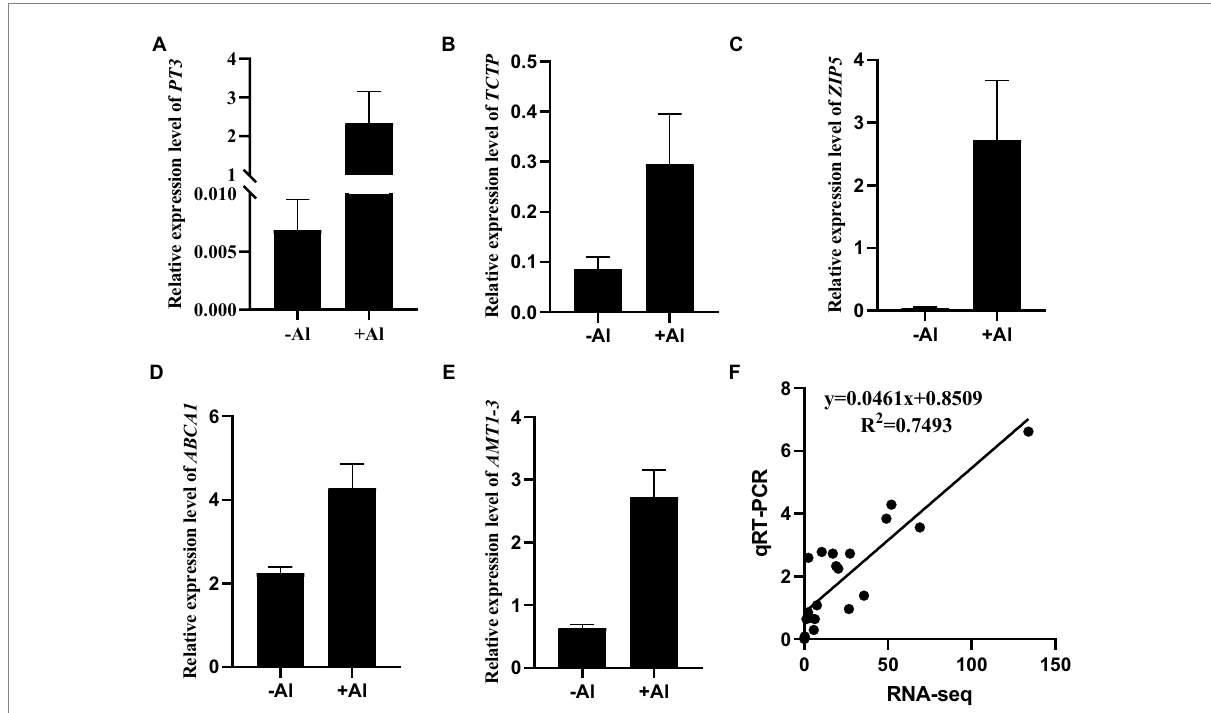
FIGURE 4 Validation of gene expression by qRT-PCR. (A – E) RT-qPCR analysis of gene expression of PT3 (A) , TCTP (B) , ZIP5 (C) , ABCA1 (D) , and AMT1-3 (E) in root apex of R. yunnanense Franch in response to 50 μ M Al for 6 h. ACTIN was used as an internal control to normalize expression. Data are means ± SD ( n = 3 for biological repeats). (F) Correlation of gene expression levels between RNA-Seq data and qRT-qPCR